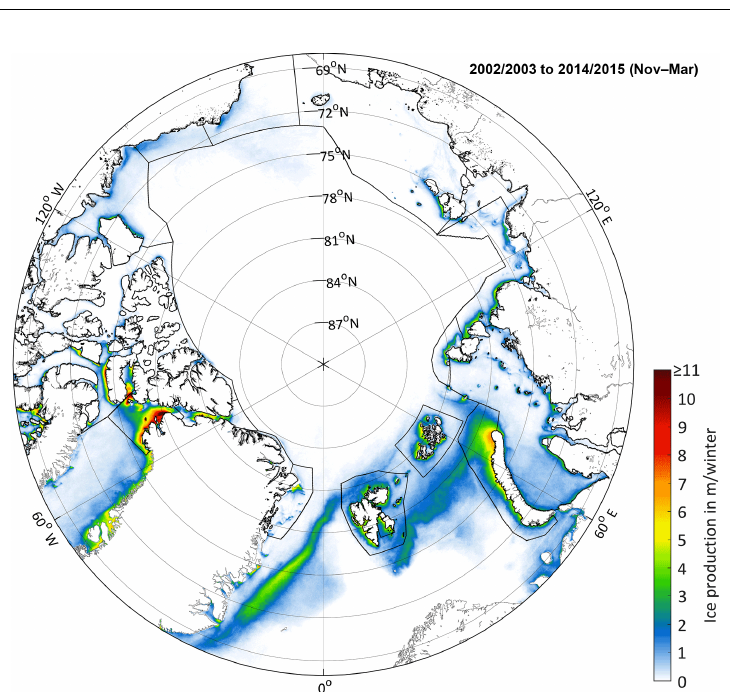
Figure 7. Average (2002/2003 to 2014/2015) accumulated ice production (m per winter) during winter (November to March) in the Arctic, north of 68 ◦ N. The margins of applied polynya masks (Fig. 1) are shown in black dashed